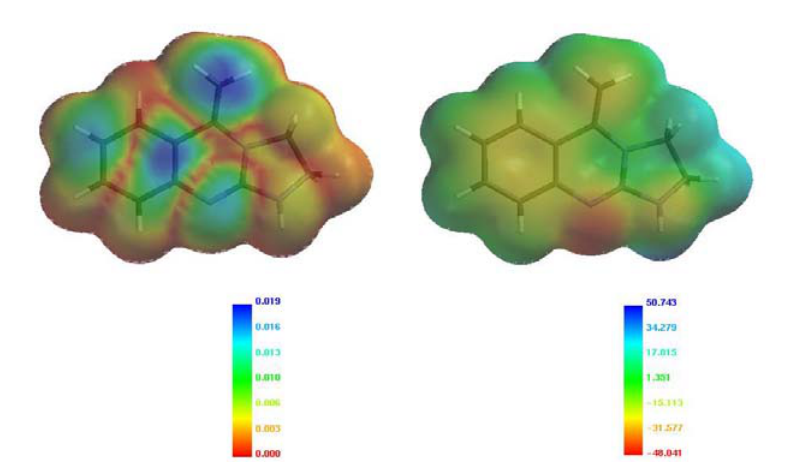
Figure 4 . Absolute values of HOMO (left) and electrostatic potential (right) mapped in color [7] onto the surface of electron density of 2